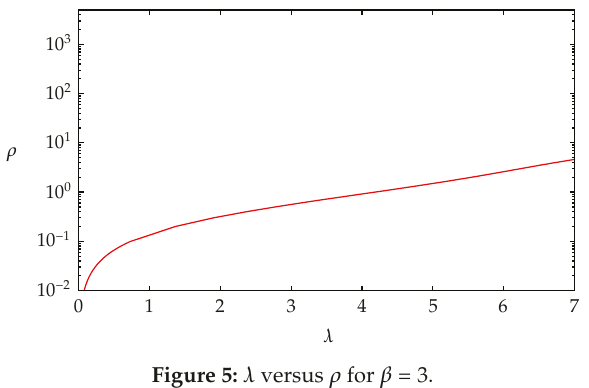
Figure 5: λ versus ρ for β (cid:3)